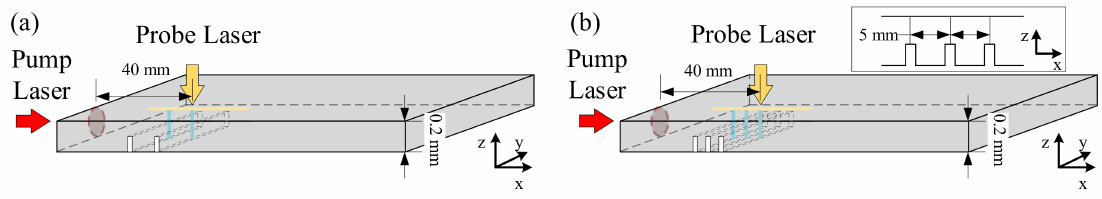
Figure 8. Configuration of the aluminum plate, the blue stripe indicates the position of probe laser on the y -axis: ( a ) two artificial notches with an interval of 10 mm; ( b ) three artificial notches with an interval of 5 mm (the inset is the enlargement of the notches in the x-z